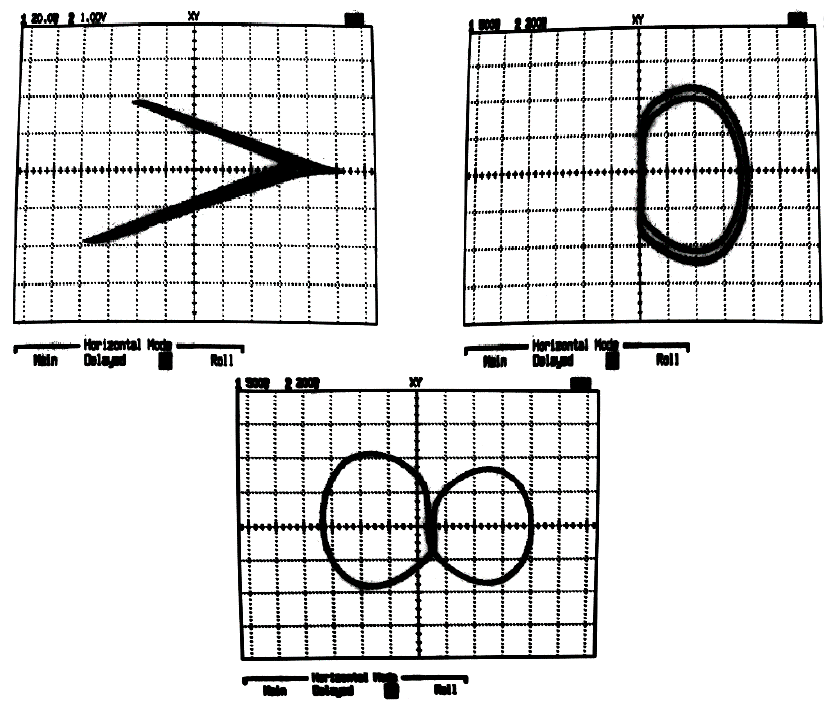
Figure 10. Centered oscilloscope screenshots: individual plane projections of observed period two limit cycle.